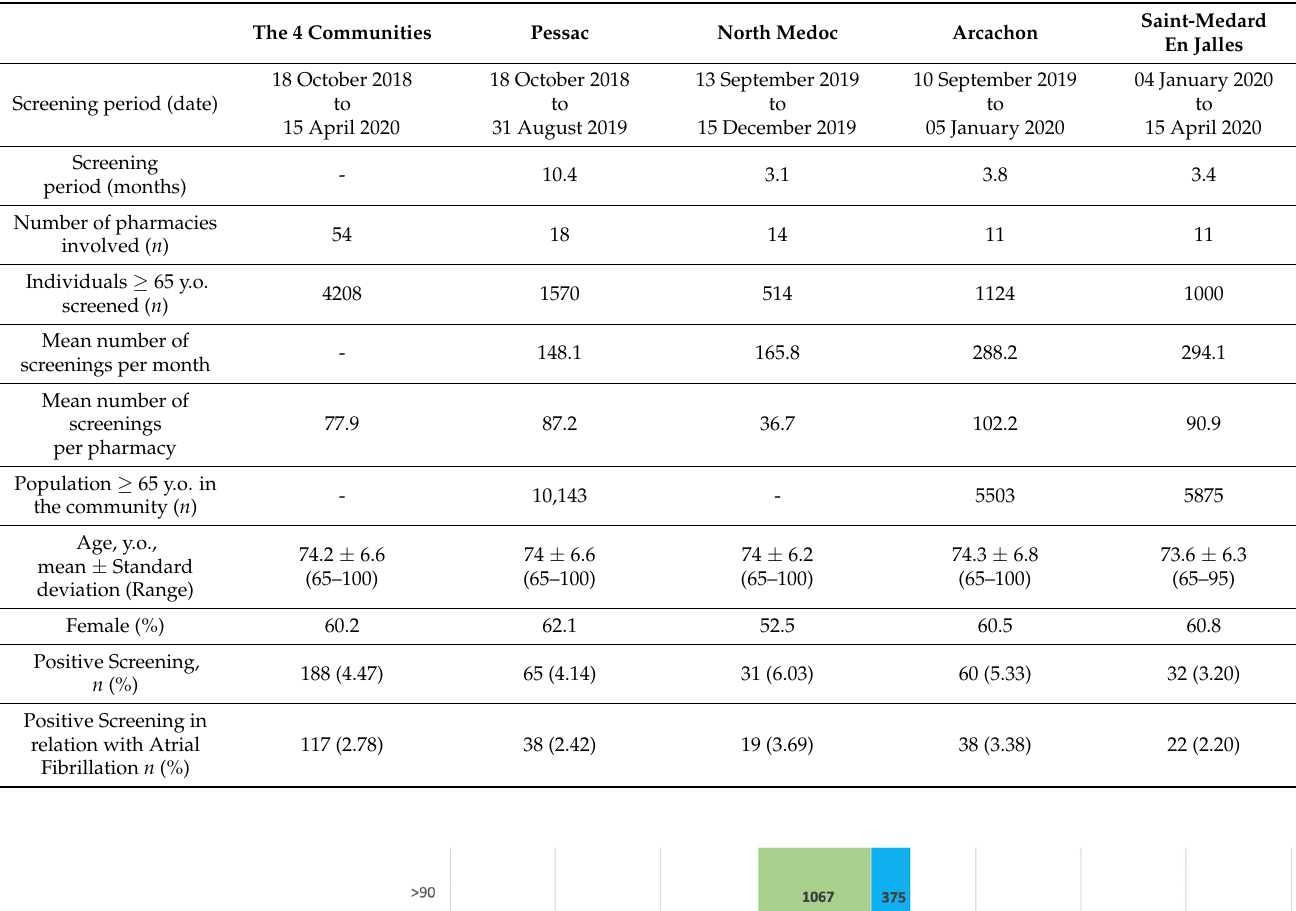
Table 1. Characteristics of the 4 campaigns of atrial fibrillation screening.